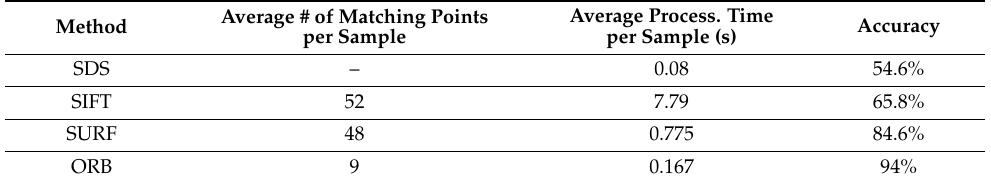
Table 14. Results comparison between the SDS, SIFT, SURF, and ORB systems over the 500 blood samples.